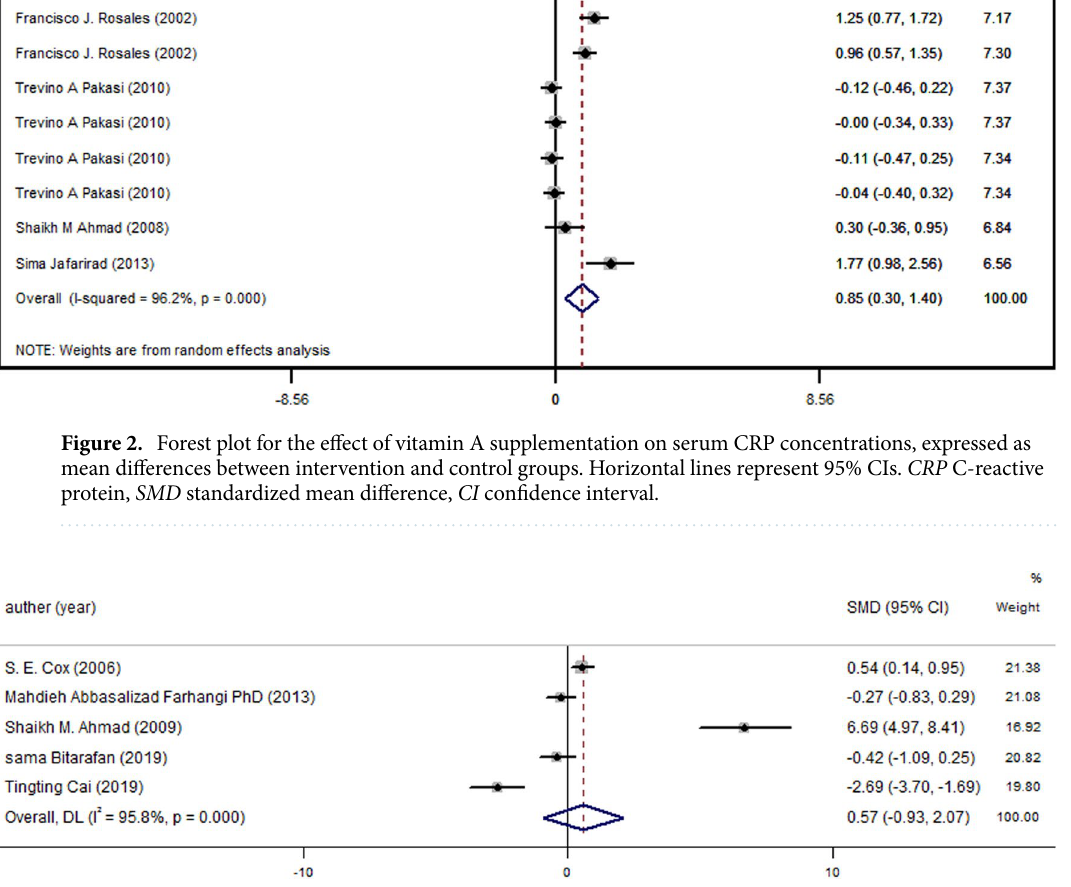
Figure 3. Forest plot for the effect of vitamin A supplementation on serum TNF-α concentrations, expressed as mean differences between intervention and control groups. Horizontal lines represent 95% CIs. TNF-α tumor necrosis factor-α, SMD standardized mean difference, CI confidence